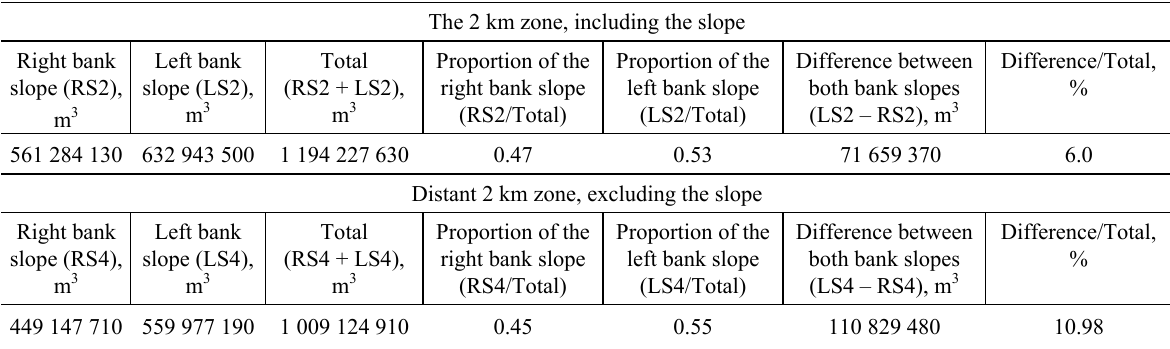
Fig. 7. Whisker plot displaying median, 25th percentile, 75th percentile, minimum and maximum of six data sets. On the right side of the plot an arithmetical mean ( ) x and a standard deviation ( s ) of data sets are